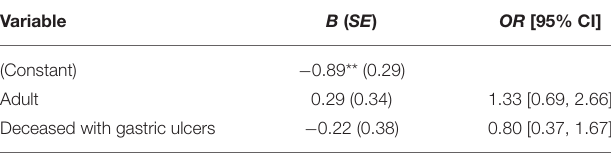
TABLE 2 | Binomial regression estimation for cachexia ( n = 187).